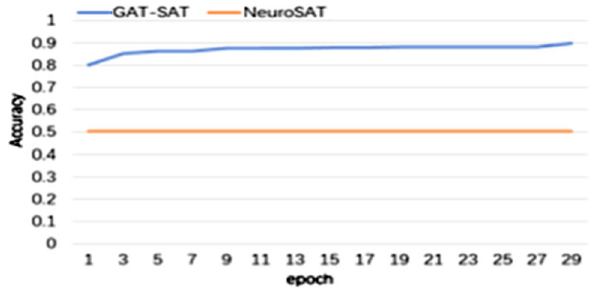
Fig. 4 SR(10, 40) comparison of results of each epoch